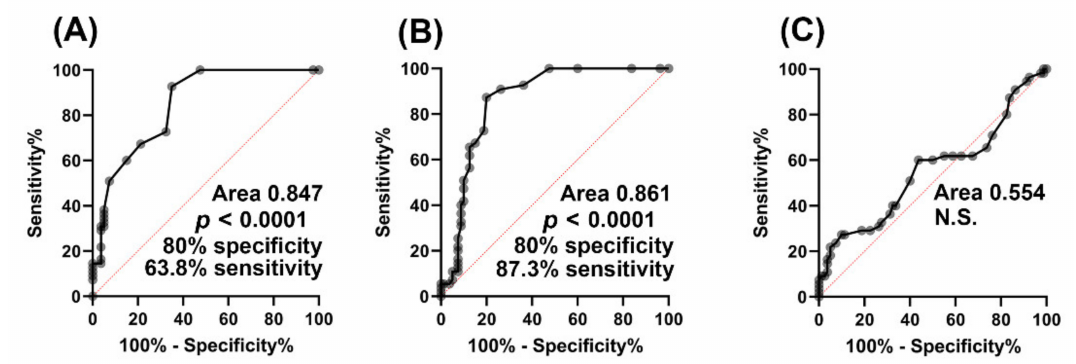
Figure 6. Receiver Operating Characteristic (ROC) curves for ( A ) plasma (2 R )-hydroxyglutaric acid (2R-HG), ( B ) plasma (2 R ,3 S )-dihydroxybutanoic acid (2,3-DHBA), and ( C ) (3 S )-methyl-2-oxovaleric acid (3M2OVA) for mutant IDH1R132 and IDH2R140 vs. WT IDH1 / 2. Both plasma 2R-HG and